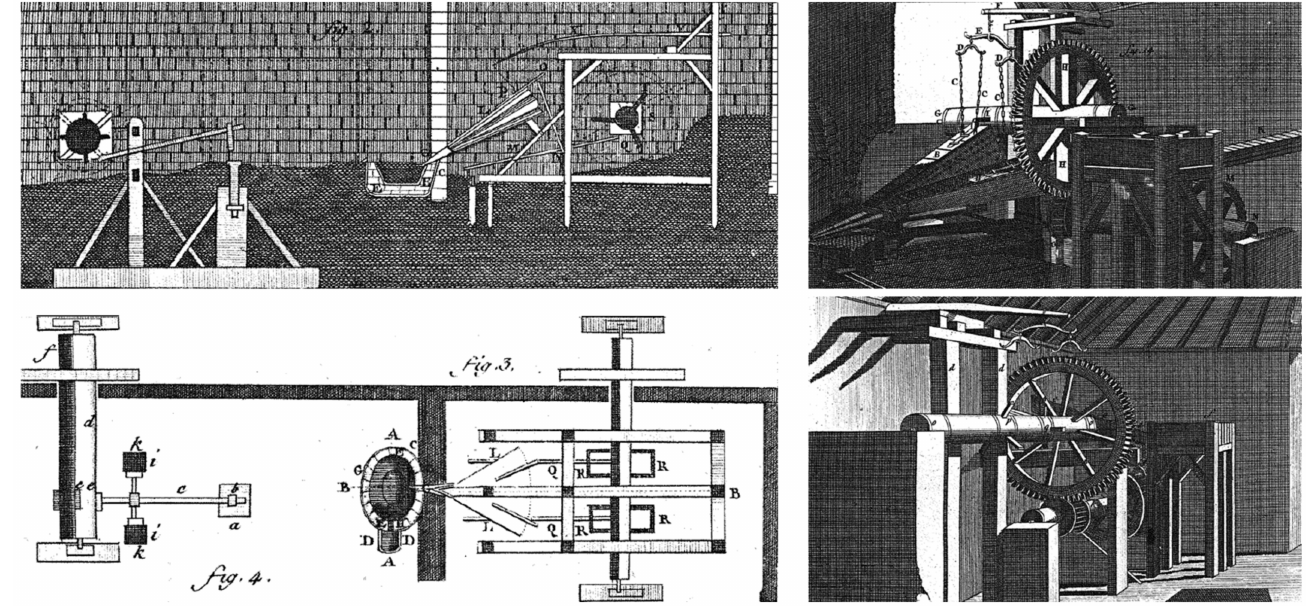
Figure 7. Ironworks and bellows drive. Source: Bertrand (1774) [54].